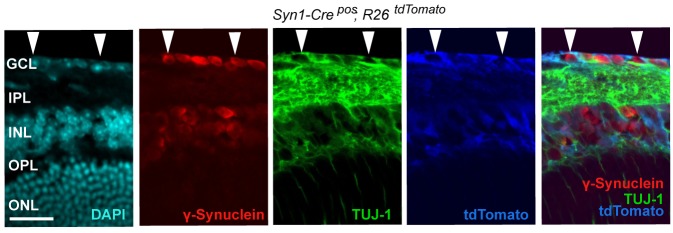
Syn1-Cre activity in the retina, illustrated by Syn1-Cre;R26LSL.tdTomato (blue) expression co-localizing with TUJ-1 (green) and γ-synuclein (red) immunolabeled RGCs in the GCL.DAPI labeled nuclei (cyan). GCL = ganglion cell layer.